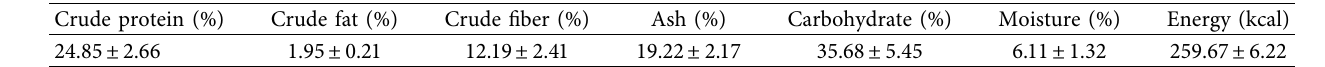
Table 2: Gross chemical composition of chard (dry weight basis).